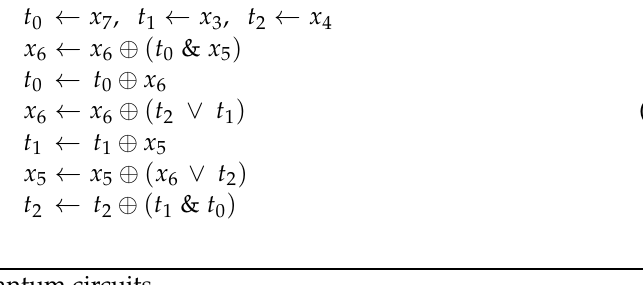
Algorithm 5 Sbox new1 in quantum